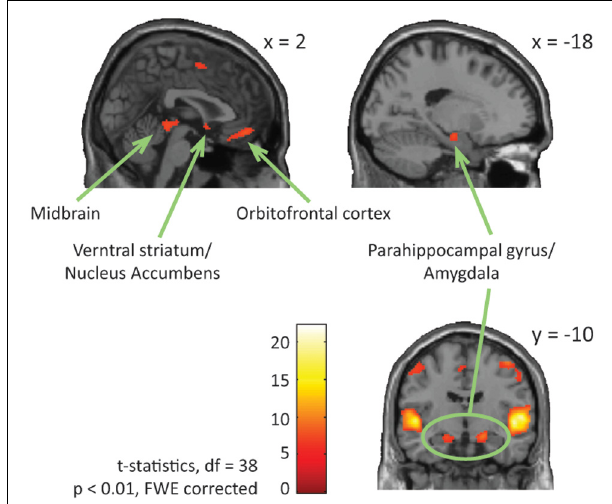
FIGURE 4 | ASD and NT—main effect of emotional vs. neutral music. The figure shows brain activations in response to emotional compared to neutral music across all participants, including activations in midbrain, parahippocampal gyrus extending into amygdala, ventral striatum/nucleus accumbens, and orbitofrontal cortex.